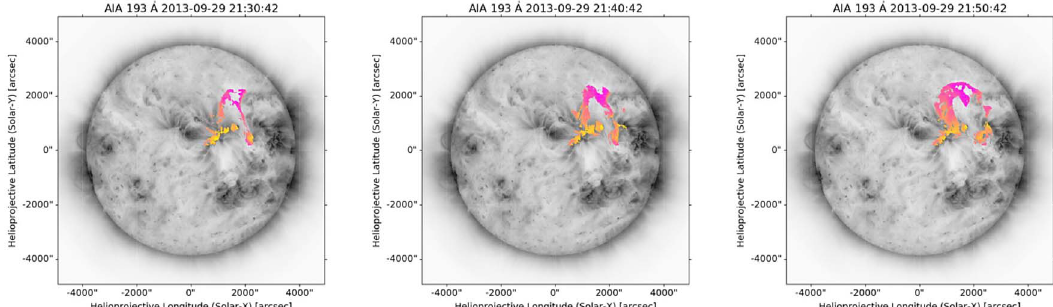
Fig. 6. Tracking of September 29, 2013, large-scale eruptive fi lament with Wavetrack is shown here for three snapshots early in the event, separated by 10 min